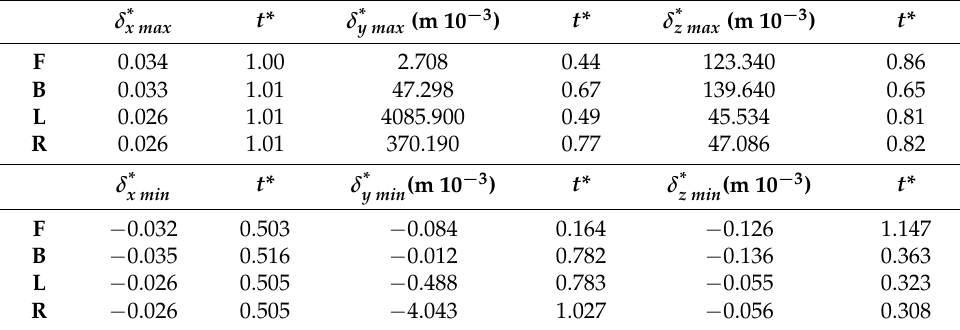
Table 1. Maximum and minimum displacements in each direction of the reference points, with the corresponding time, in the first simulated period after the transient phase (0.25 ≤ t* ≤